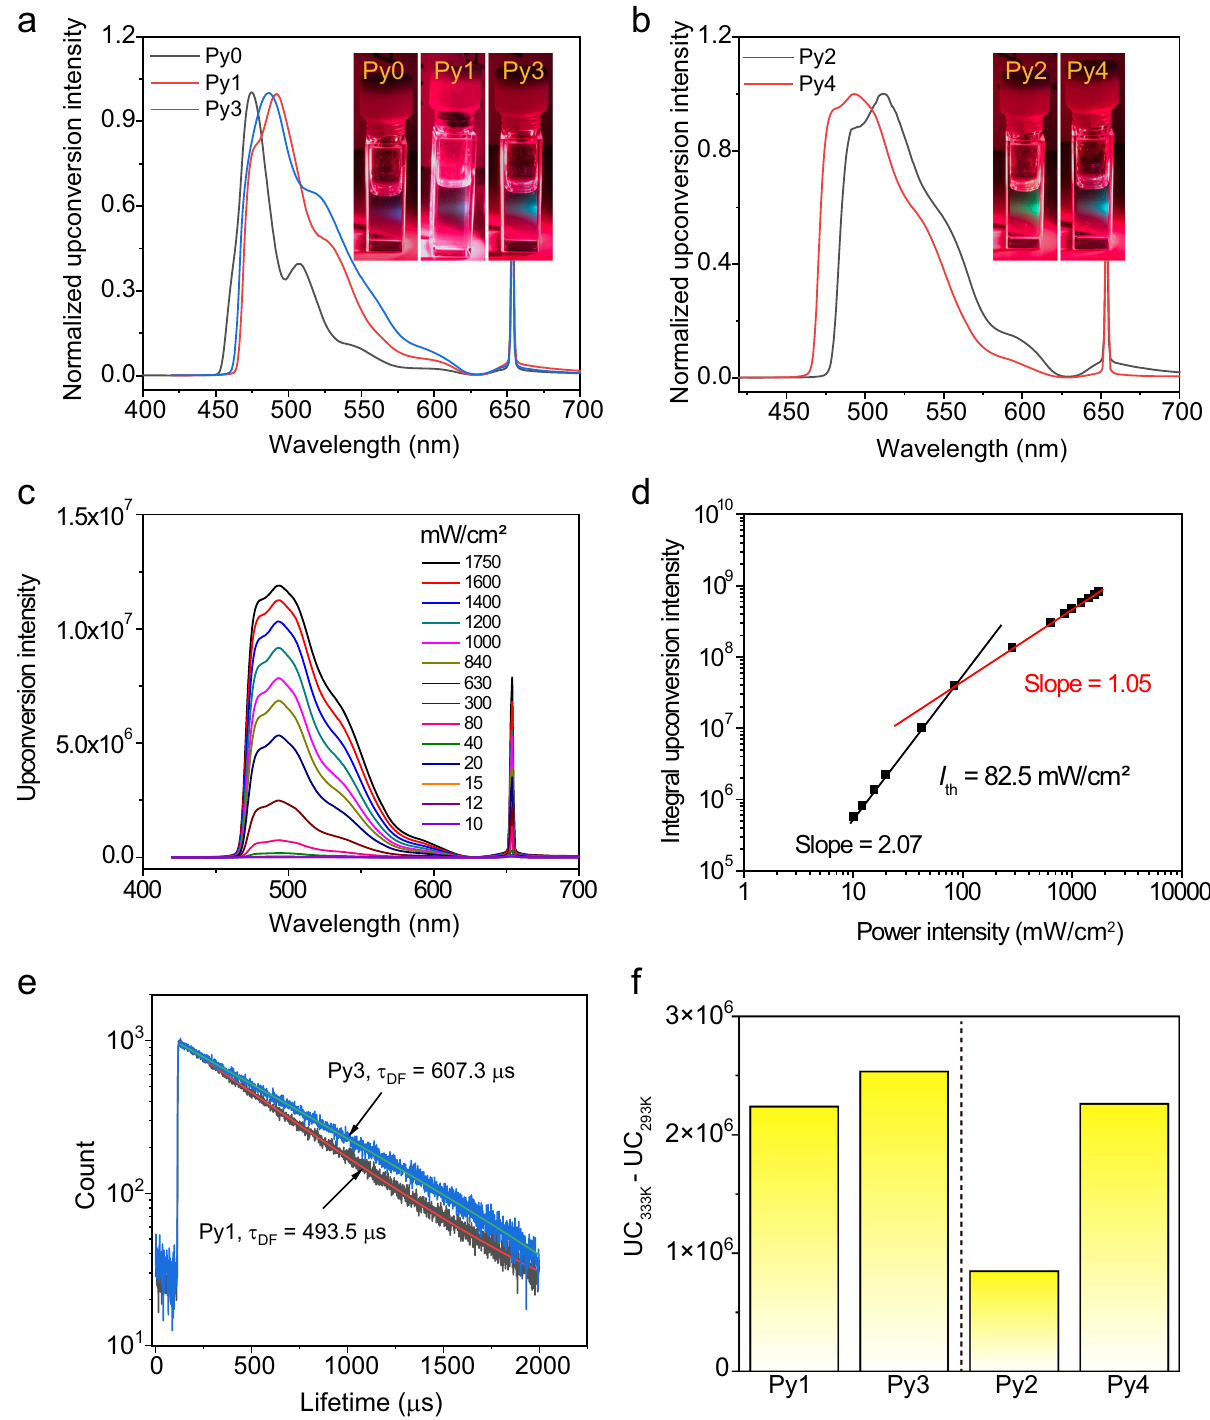
Fig. 3 | Characterization of the TTA-UC properties for PdTPBP with Py0-Py4. Normalized TTA-UC spectra for PdTPBP with annihilators of ( a ) Py0, Py1, Py3 and ( b ) Py2, Py4. The inserted images are the associated TTA-UC pictures. c Upconversion emission spectra of PdTPBP/Py4 with various excitation inten- sities. d The dependence of the TTA-UC intensity of PdTPBP/Py4 on the incident power density. The fi tting lines have slopes of 2.07 (black, below) and 1.05 (red,